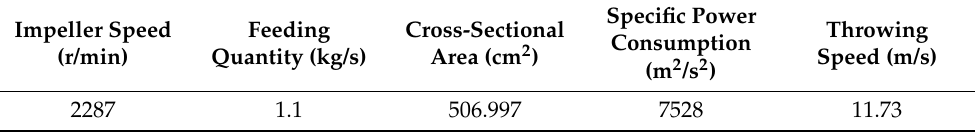
Table 6. Optimization of process parameters and corresponding optimal results.